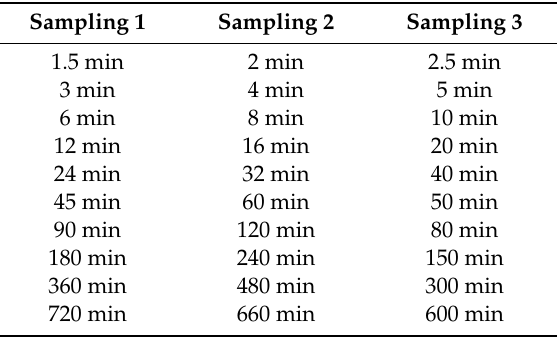
Table 4. Sampling schedule for extraction